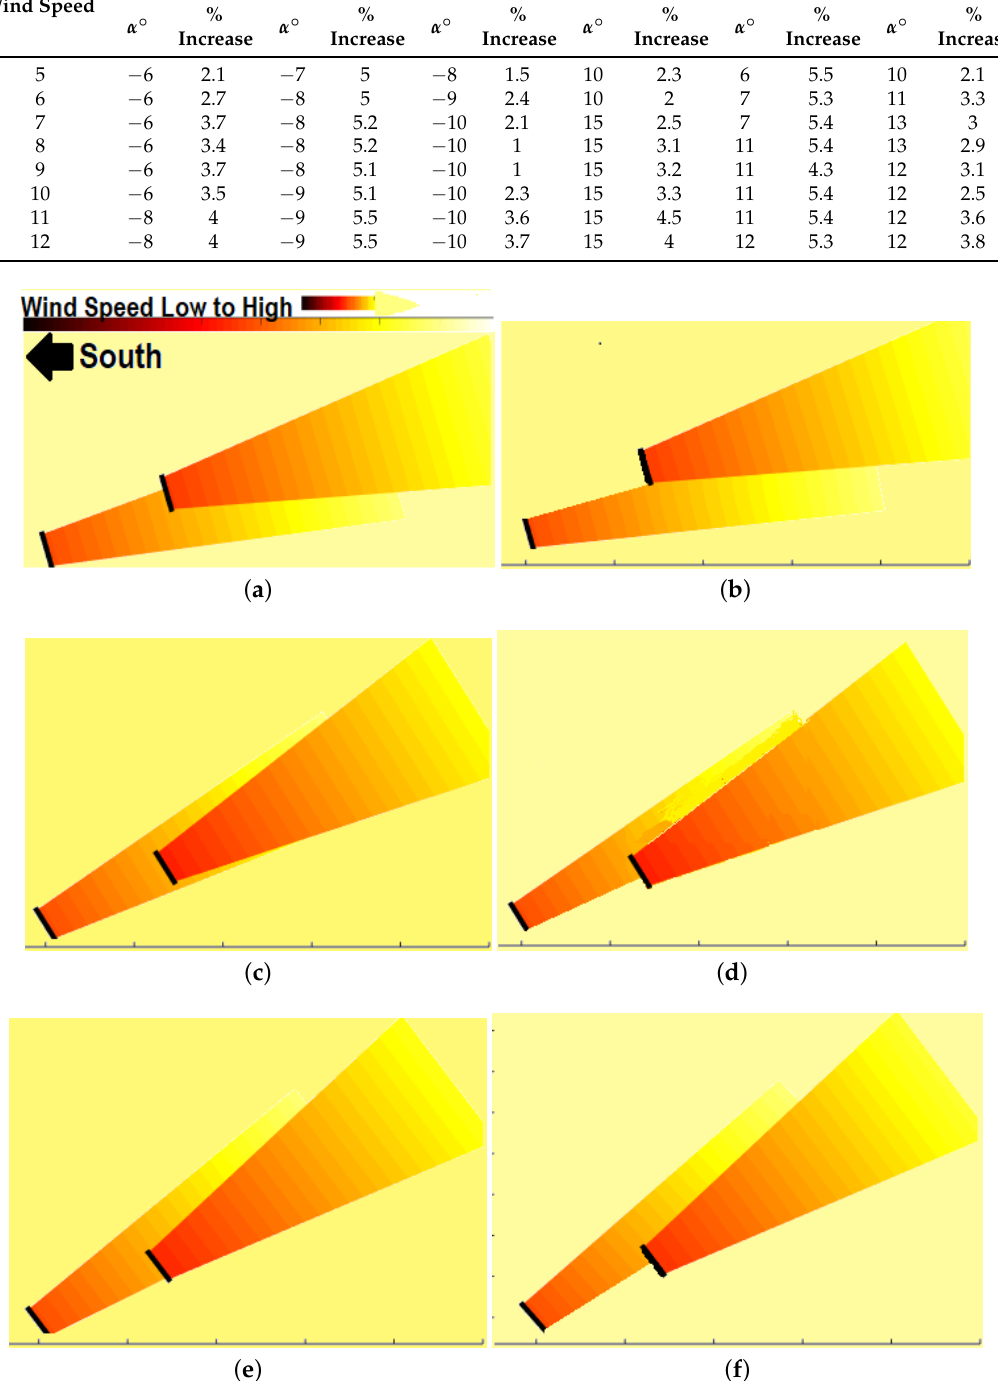
Figure 6. Simulated comparison of greedy and optimised control strategies in partial and full wake conditions ( a ) 196 ◦ –200 ◦ Greedy; ( b ) 196 ◦ –200 ◦ Optimised; ( c ) 206 ◦ –210 ◦ Greedy; ( d ) 206 ◦ –210 ◦ Optimised; ( e ) 211 ◦ –215 ◦ Greedy; ( f ) 211 ◦ –215 ◦